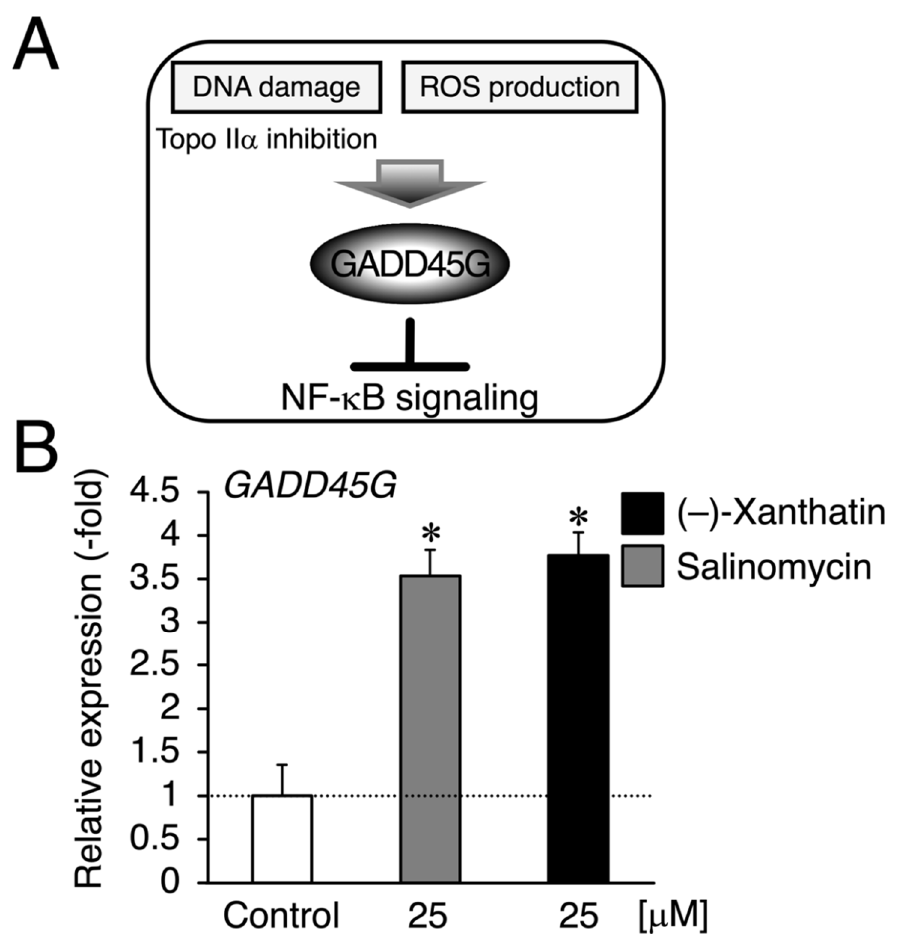
Figure 3. (–)-Xanthatin- and salinomycin-mediated up-regulation of the expression of growth arrest and DNA damage-inducible 45 gamma ( GADD45G ) in mammospheres derived from MCF-7 cells. ( A ) We reported that (–)-xanthatin has the ability to inhibit Topo II α as a catalytic inhibitor as well cancer cells [5–7,9,11]. ( B ) Real-time RT-PCR analysis of GADD45G in mammospheres after 72 h of the treatment with vehicle, 25 µ M (–)-xanthatin, or 25 µ M salinomycin. Data are presented as the mean ± S.E. ( n = 3) of the fold induction compared to the vehicle-treated control. * Significant differences ( p < 0.05) from the vehicle-treated control.